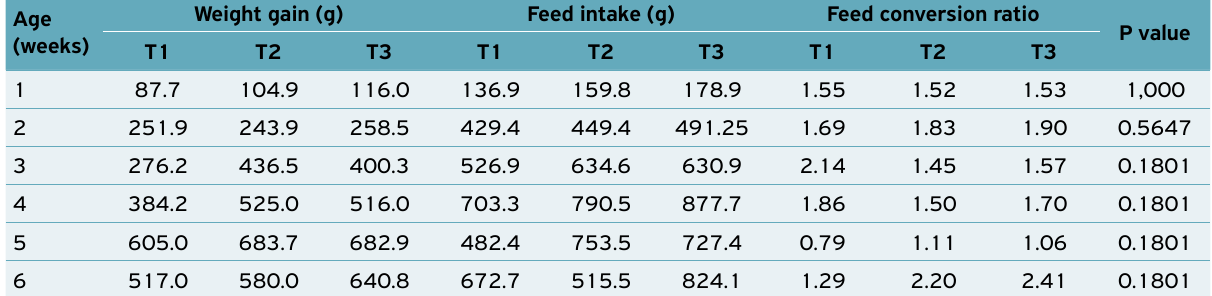
Table 2. Performance of broilers fed with extract of inulin (T1), inulin with Bifidobacterium (T2) and negative control (T3): Test 3. Age (weeks)